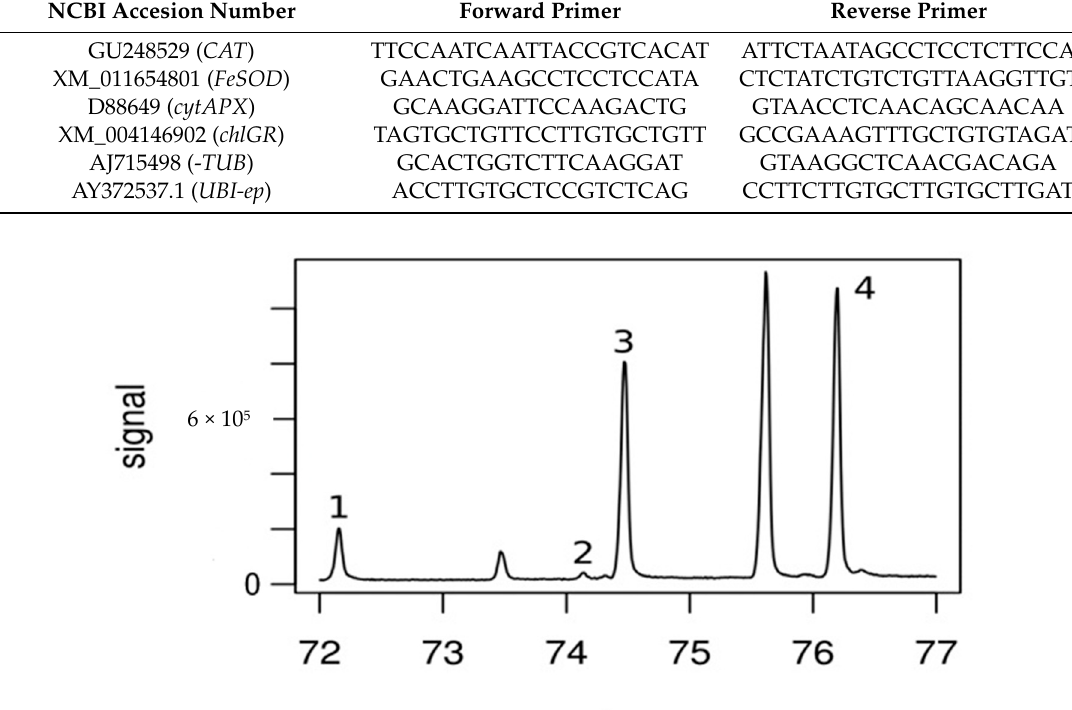
2, 5, and 7 dai after inoculation. and 7 dai after inoculation.